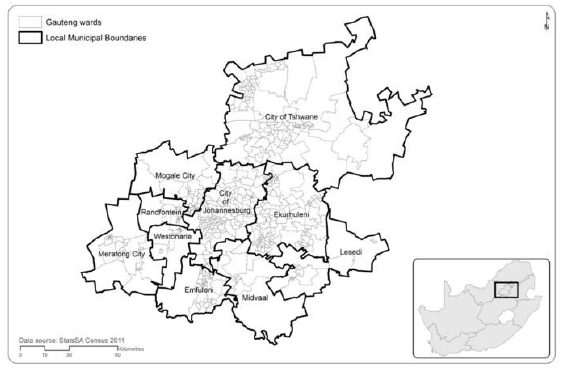
Figure 1. Gauteng province (study area)